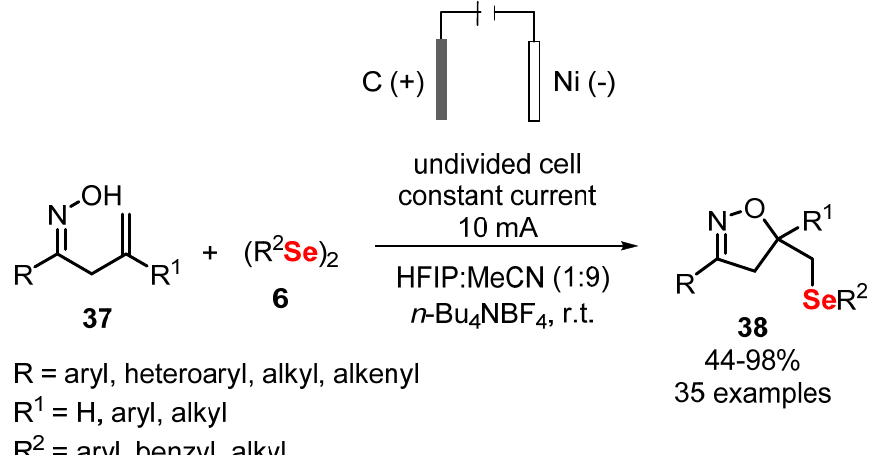
Scheme 25. Electrochemical oxidative tandem cyclization for the synthesis of selenium ‐ containing isoxazolines derivatives 38 with quaternary carbon